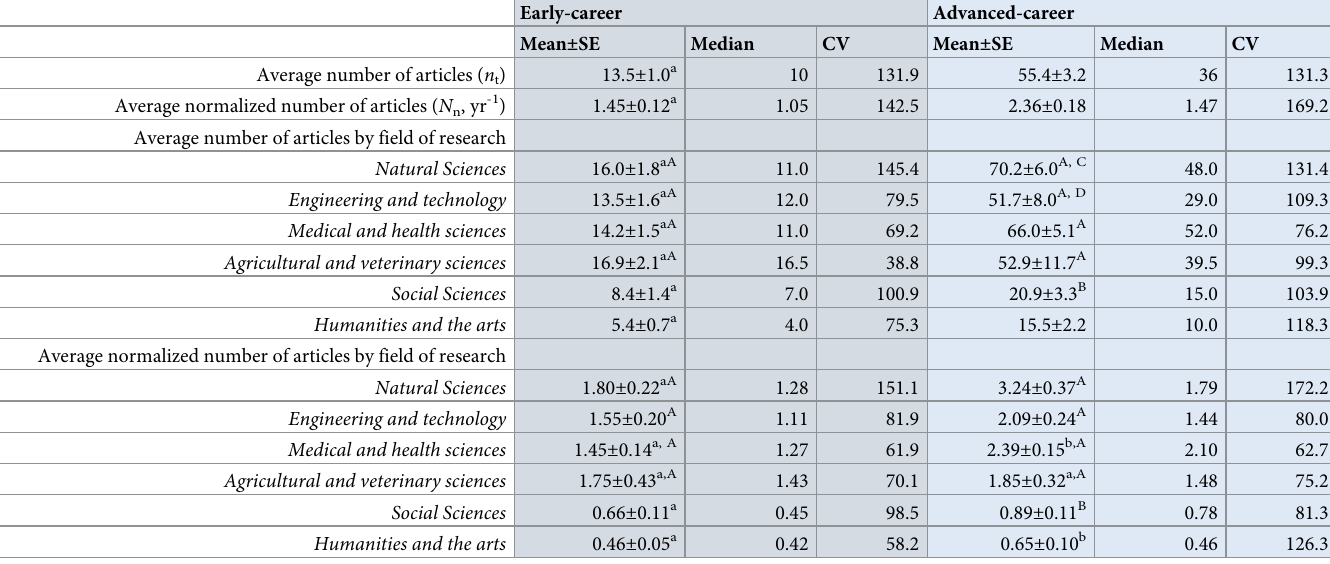
Table 4. Average number of peer-reviewed articles and age-normalized number of articles published by grant holders for different grant types across different fields of science for grants awarded by the Estonian Research Council between 2013–2022 (Research question 2).